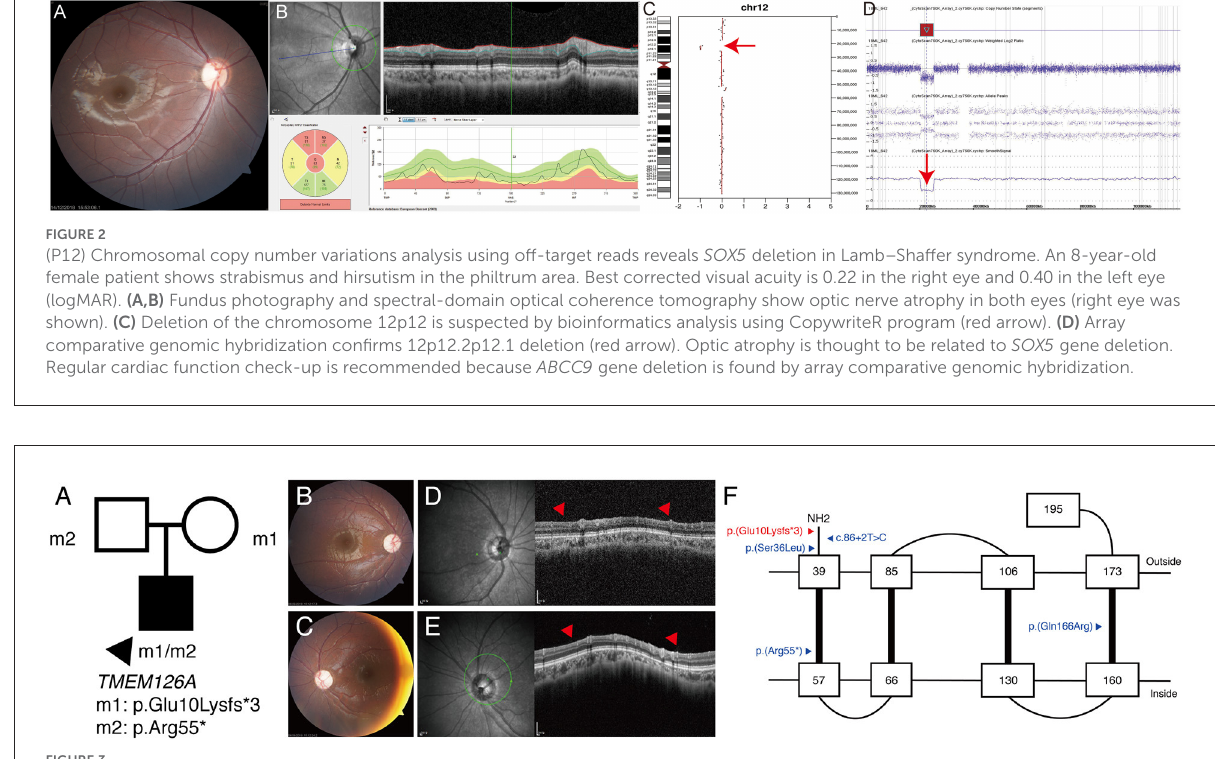
FIGURE3 (P16) TMEM126A optic atrophy. The best-corrected visual acuity is 1.70 in the right eye and 1.40 in the left eye (logMAR). (A) Segregation analysis revealing the presence of compound heterozygous TMEM126A variants. (B,C) Fundus photographs showing diffuse optic atrophy (D,E)